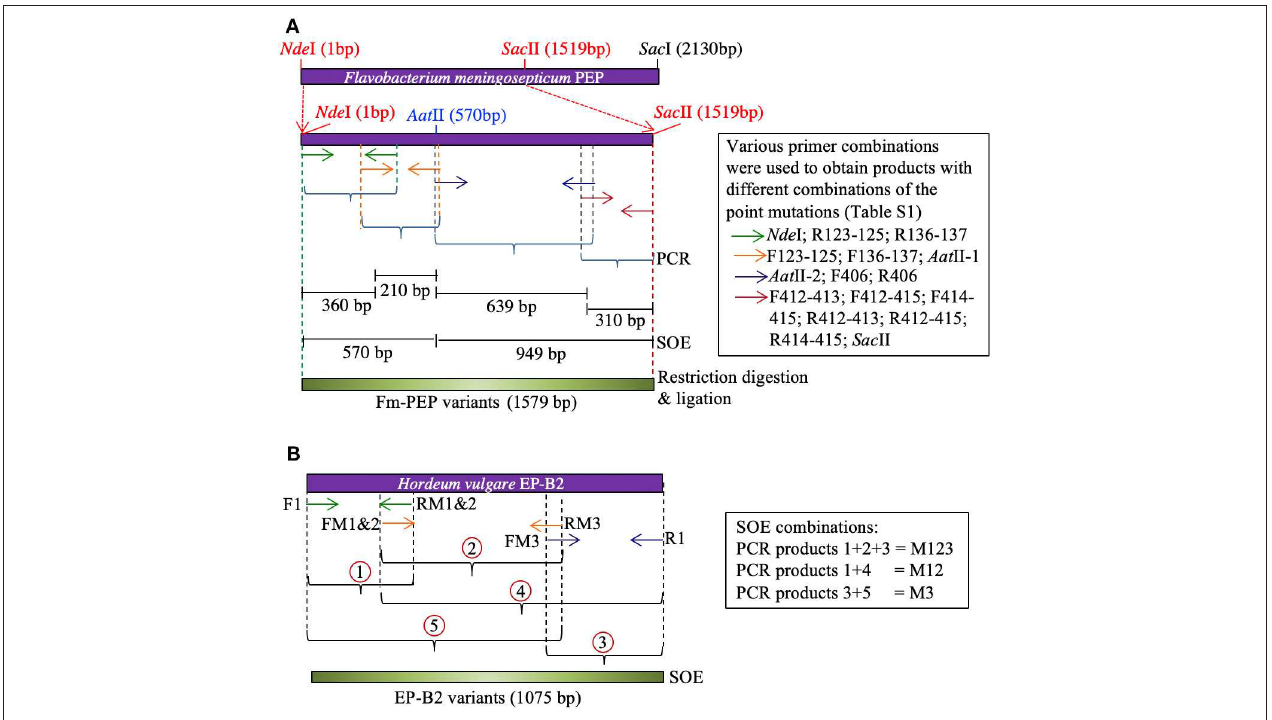
FIGURE 1 | Schematic representation of Splicing by Overlapping Extension (SOE)-PCR used as a strategy to introduce mutations in the genes encoding (A) Flavobacterium meningosepticum prolyl endoprotease, and (B) Hordeum vulgare cysteine endopeptidase B2. Corresponding primers are shown as same color arrows. For primer sequences, see Table S1